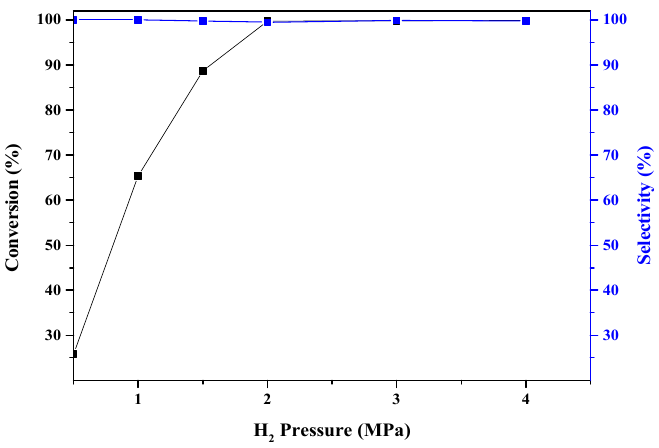
Figure 7. Impact of reaction pressure on the conversion (black) and selectivity (blue) in the selective hydrogenation of p ‐ chloronitrobenzene ( p ‐ CNB). Reaction conditions: 1 g 0.27 wt % modified Pd/ γ ‐ Al 2 O 3 @ASMA treated with 100 g/L morpholine, 1 g p ‐ CNB dissolved in 50 mL ethanol, 80 °C, 600 rpm, and 4 h in a 100 mL autoclave.